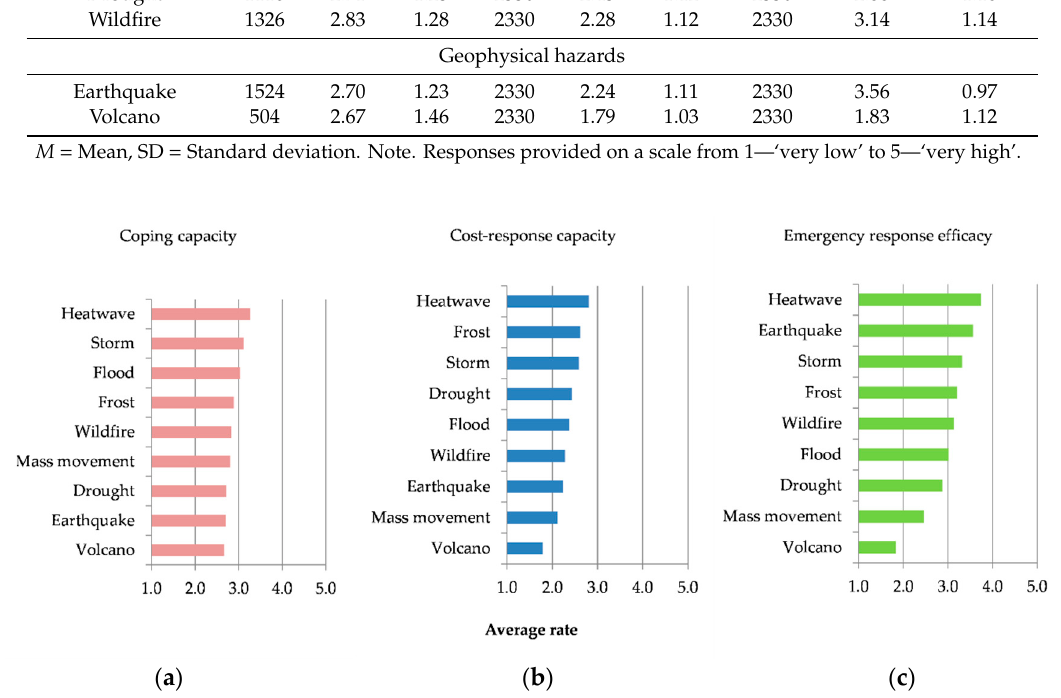
Figure 5. Average ratings assigned by the participants to the nine types of natural hazards survey, with regard to: ( a ) Coping capacity, ( b ) cost-response capacity, ( c ) emergency response efficacy. Geophysical hazards tend to score lower ratings, in both coping and cost-response capacity.